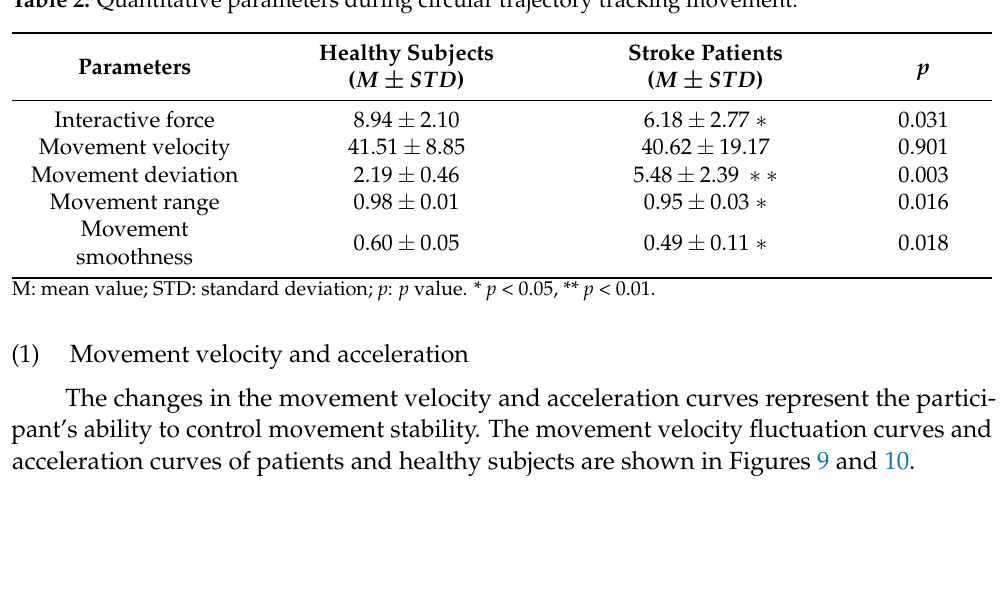
Table 2. Quantitative parameters during circular trajectory tracking